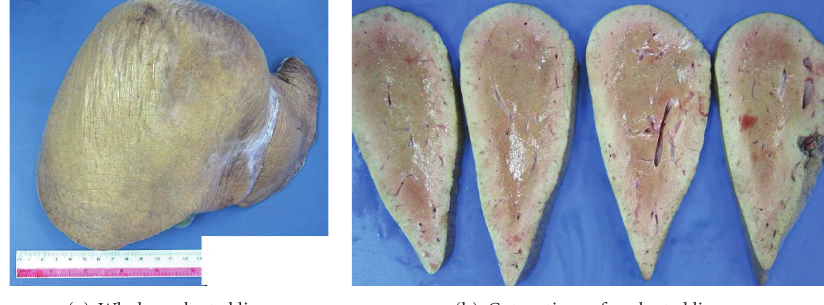
Figure 1: Gross specimen of explanted liver.